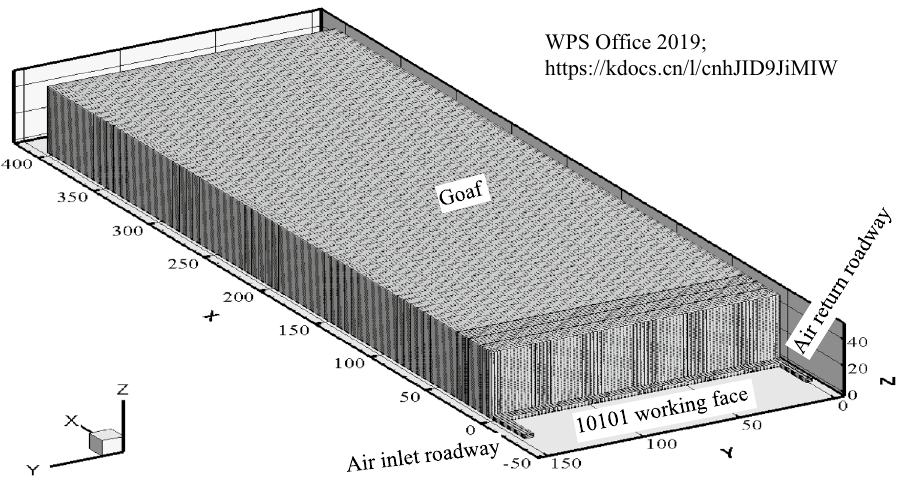
Figure 4. 3D dynamic geometric model of